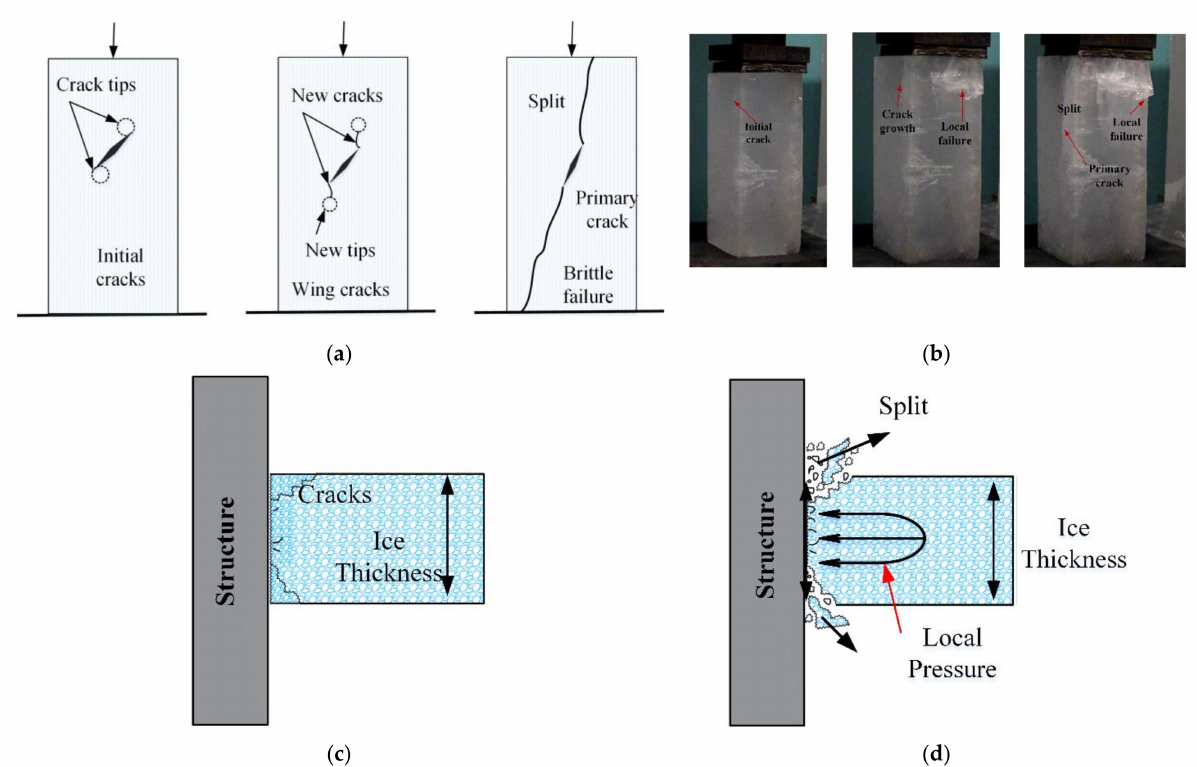
Figure 2. Crack growth at low loading speeds and the theoretical crushing process in front of the vertical structure. ( a ) Schematic of internal crack propagation, ( b ) Uniaxial compressive test at a strain rate of 10 − 4 s − 1 , ( c ) Initial crack formation in the sea ice in front of the structure, ( d ) Local ice pressure and ice fragmentation